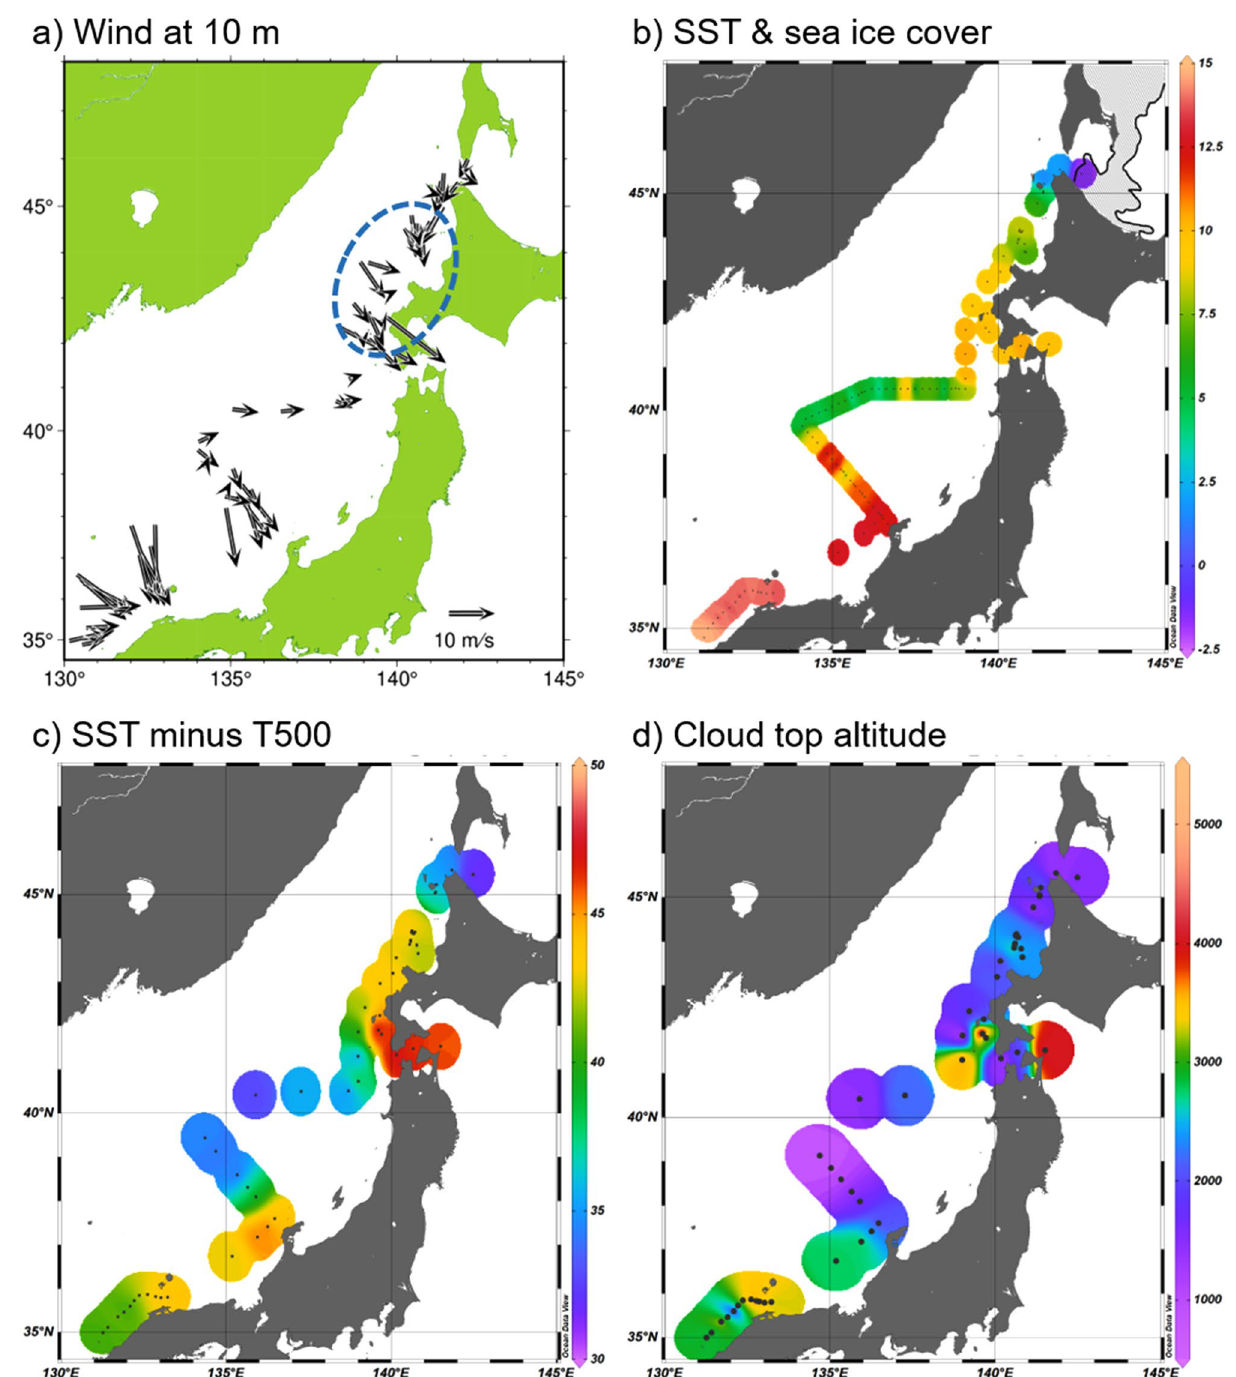
Figure 4. Observed air sea conditions during entire observation period. ( a ) Observed wind vector at altitude of 10 m. In addition to the JPCZ area, the vortex-like wind distribution is observed off the coast of Hokkaido. ( b ) Observed sea surface temperature (unit: °C). The light grey shading north of Hokkaido represents sea ice cover areas on the day the training vessel reached the ice margin. ( c ) Sea surface temperature minus 500-hPa atmospheric temperature. The weakness of vertical stratification is indicated by this value, and a 43 °C difference is the criterion for the occurrence of a polar low 19 . Temperature differences (unit: °C) larger than 43 °C are indicated in yellowish or reddish colours. ( d ) Cloud top altitudes (unit: